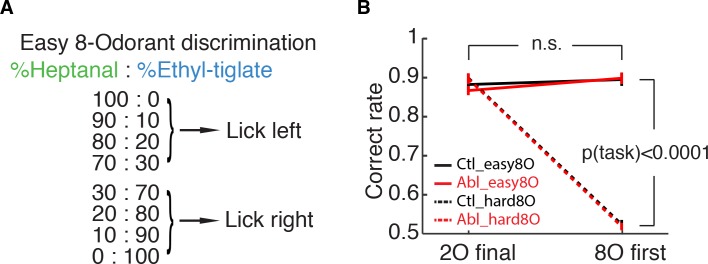
ABN ablation does not affect the performance in the easy 8-odorant discrimination. (A) Easy 8-odorant discrimination task. One of the eight mixtures is presented pseudorandomly in each trial. (B) Fraction of correct trials out of answered trials in the last session with the easy 2-odorant discrimination and the first session with the easy 8-odorant discrimination. There is no difference between two sessions for both control and ablation (control: n = 7, p=0.5350, ablation: n = 6, p=0.2229, Wilcoxon rank sum test; mean ±S.E.M.), and the overall performance in the easy 8-odorant discrimination task is significantly better than in the difficult 8-odorant discrimination task (p(task)<0.0001, three-way ANOVA).